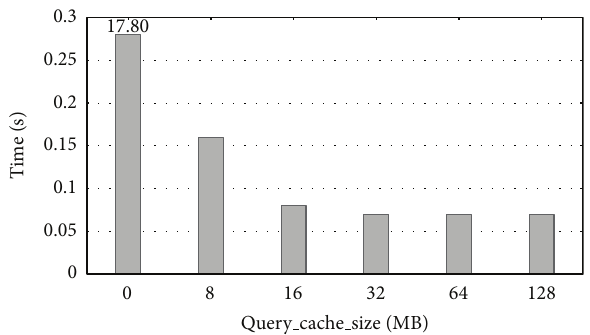
Figure 10: Runtime of a simple query.